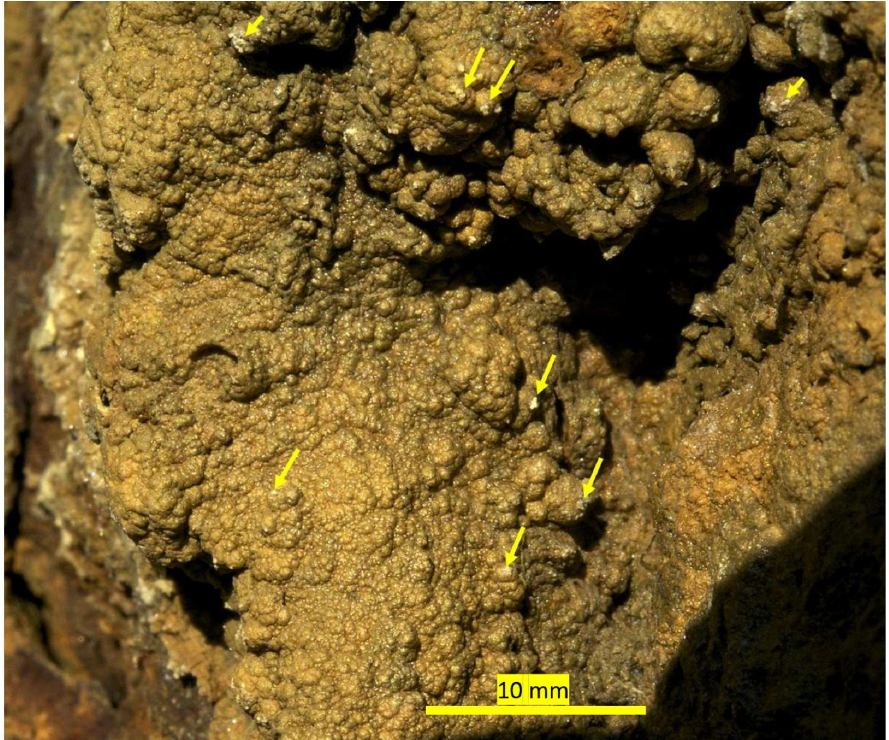
Figure 20. Jarosite formation at Stefføya site. Some tiny gypsum formations on top of the jarosite are noticeable. Some of the small gypsum formations are shown in the yellow arrows. Probably, some of them, which were dissolved, are re-precipitating to the left side of the jarosite formation at the edge (white precipitation, out of focus).